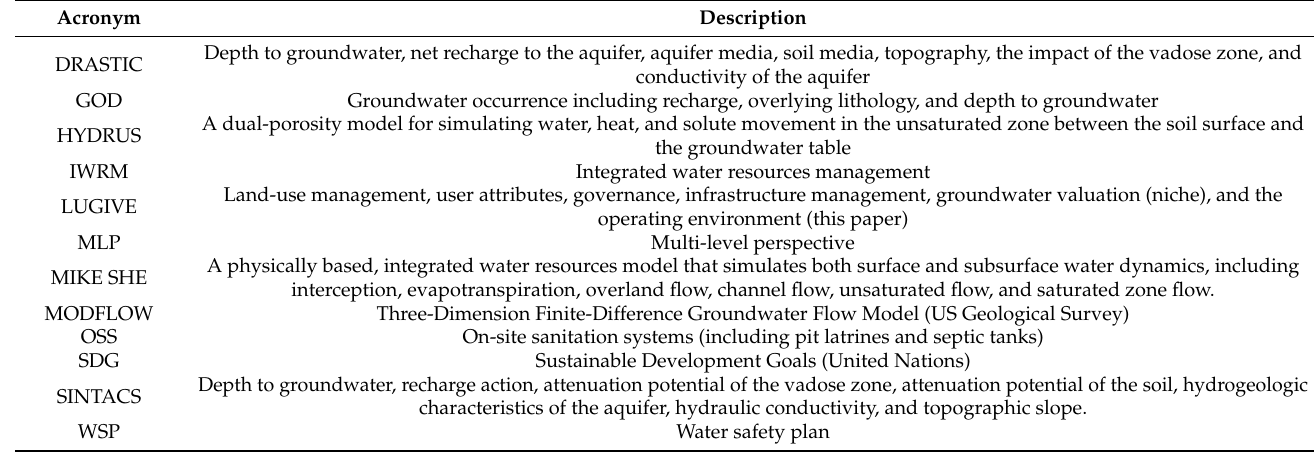
Table A1. Description of Key Acronyms Used in the